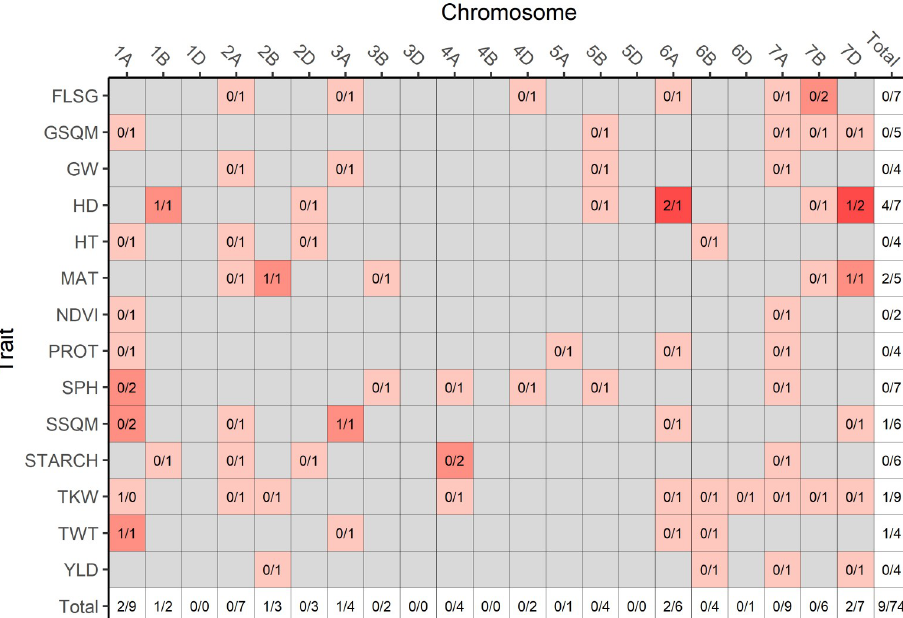
Fig 5. Distribution of MTAs across traits and chromosomes. The number of MTAs detected by the GCTA single- locus model (preceding slashes) and by the FarmCPU model (following slashes) are summed for each trait/ chromosome combination. Grey shading indicates that no MTAs were found for that particular trait/chromosome combination. Red shading is proportional to the total number of MTAs detected by both models. Marginal totals of MTAs are displayed for each trait and chromosome, with the grand total displayed in the lower right